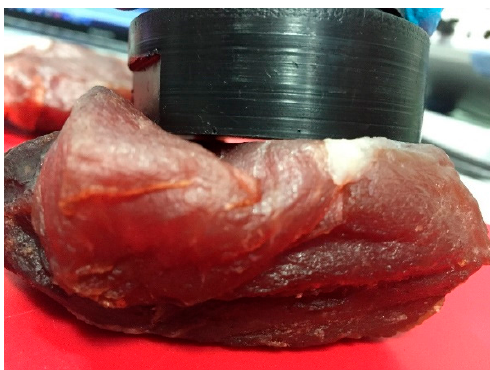
Figure 2. ( a ) Correlation between the a w and normalized sensor output at selected frequencies. PLS regression ( b ) shows the capability of the sensor in terms of measured vs. predicted aw values.